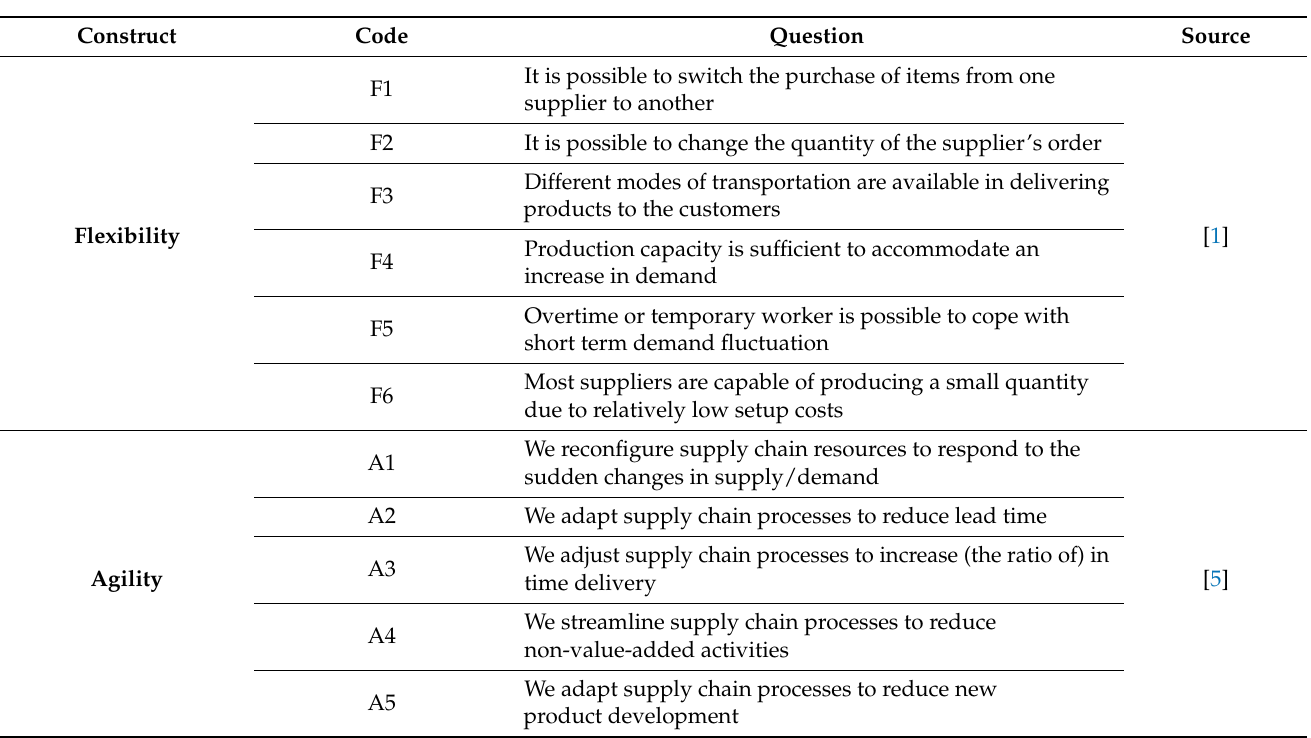
Table A1. Questionnaire